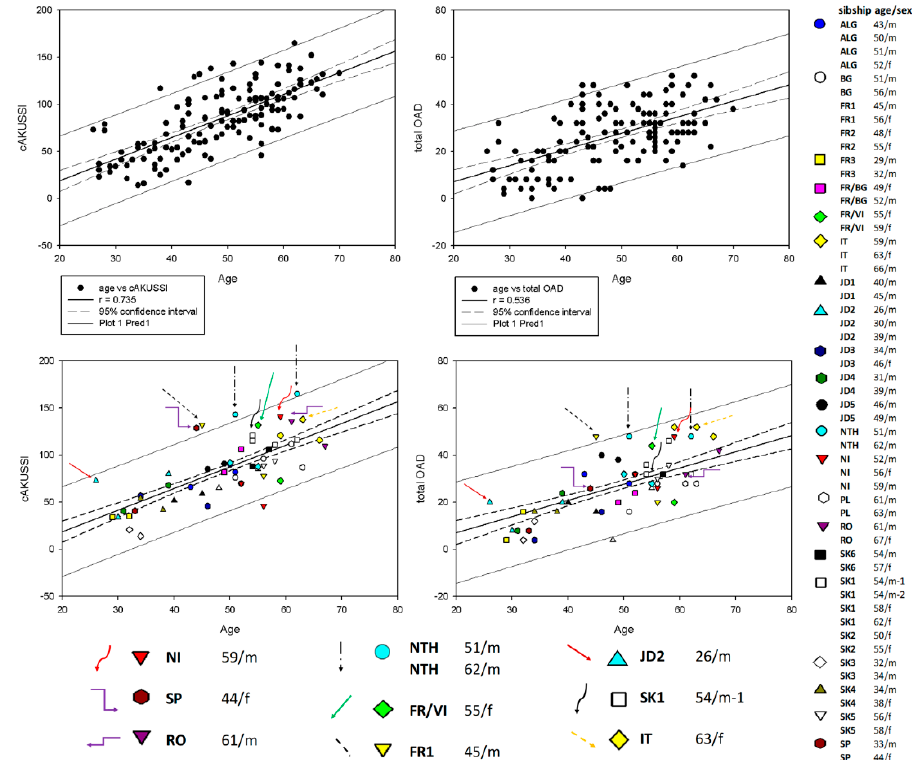
Figure 2. Pearson correlation of cAKUSSI ( left ) and total OAD ( right ) with age. Horizontal axis indicates the age of the patients. The upper panels show the regression analysis with all 139 SONIA 2 AKU patients. The lower panels show (on the background of the same chart) all 24 sibling pairs. The legend on the right-hand side indicates individual sibling pairs or groups, with age (in years) and sex indicated. Colored arrows indicate specific patients discussed in the text.